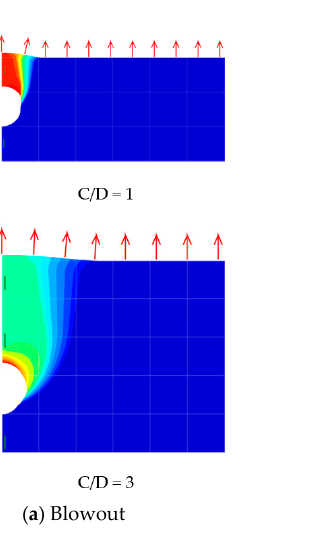
( b) Collapse Figure 19. Absolute velocity (|u|) contour plot ( B/D = 2). 4. Comparison and Examples Since there was no previous study on the soil stability of elliptical-shaped cavity un- der blowout condition, the comparison in Figure 20 is made by using previous circular cavity results (i.e., B = D ) in either blowout or collapse scenarios. To compare the current pressure ratio ( PR ) with the critical stability number ( N c ) in Shiau and Al-Asadi [35], a weightless soil condition ( γ D/S u = 0) is needed. In this way, our pressure ratio ( PR ) is equal to the ( N c ) reported in Shiau and Al-Asadi [35]. The comparison shows a good agreement between Shiau and Al-Asadi [35] and the present study for the blowout study. Similarly, for the collapse study, it also shows a good arrangement amongst Shiau and Al-Asadi [35], Wilson et al. [36] and the present study. This comparison has greatly enhanced the